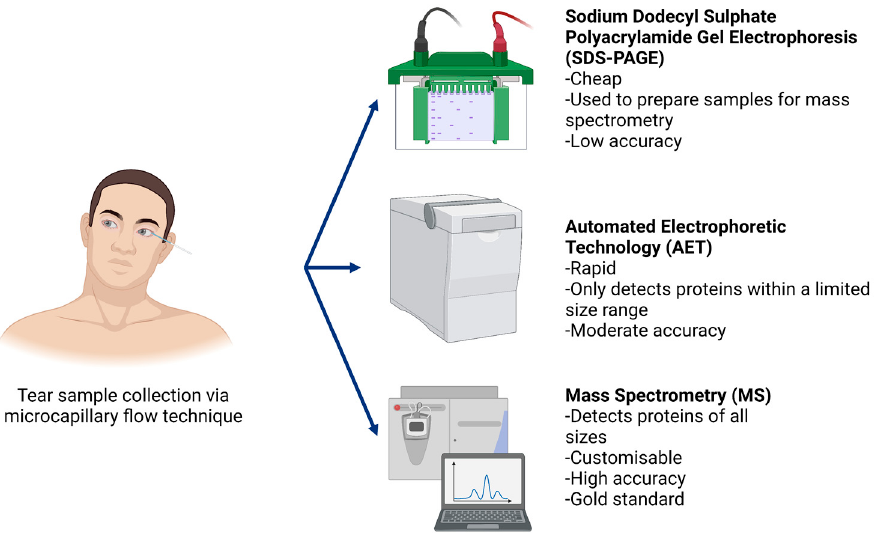
Figure 2. In order to collect human tear samples using the microcapillary flow technique, participants were asked to sit facing forward with their heads tilted all the way to one side to ensure basal tears from the surface of the eye pooled in the lateral canthus (outer corner of the eye). With sterile, gloved hands, glass microcapillary tubes were used to draw tears from the ocular surface. Following sample collection, proteome analysis is typically conducted using sodium dodecyl sulphate polyacrylamide gel electrophoresis (SDS-PAGE), automated electrophoretic technology (AET) or mass spectrometry techniques (in order of increasing accuracy).